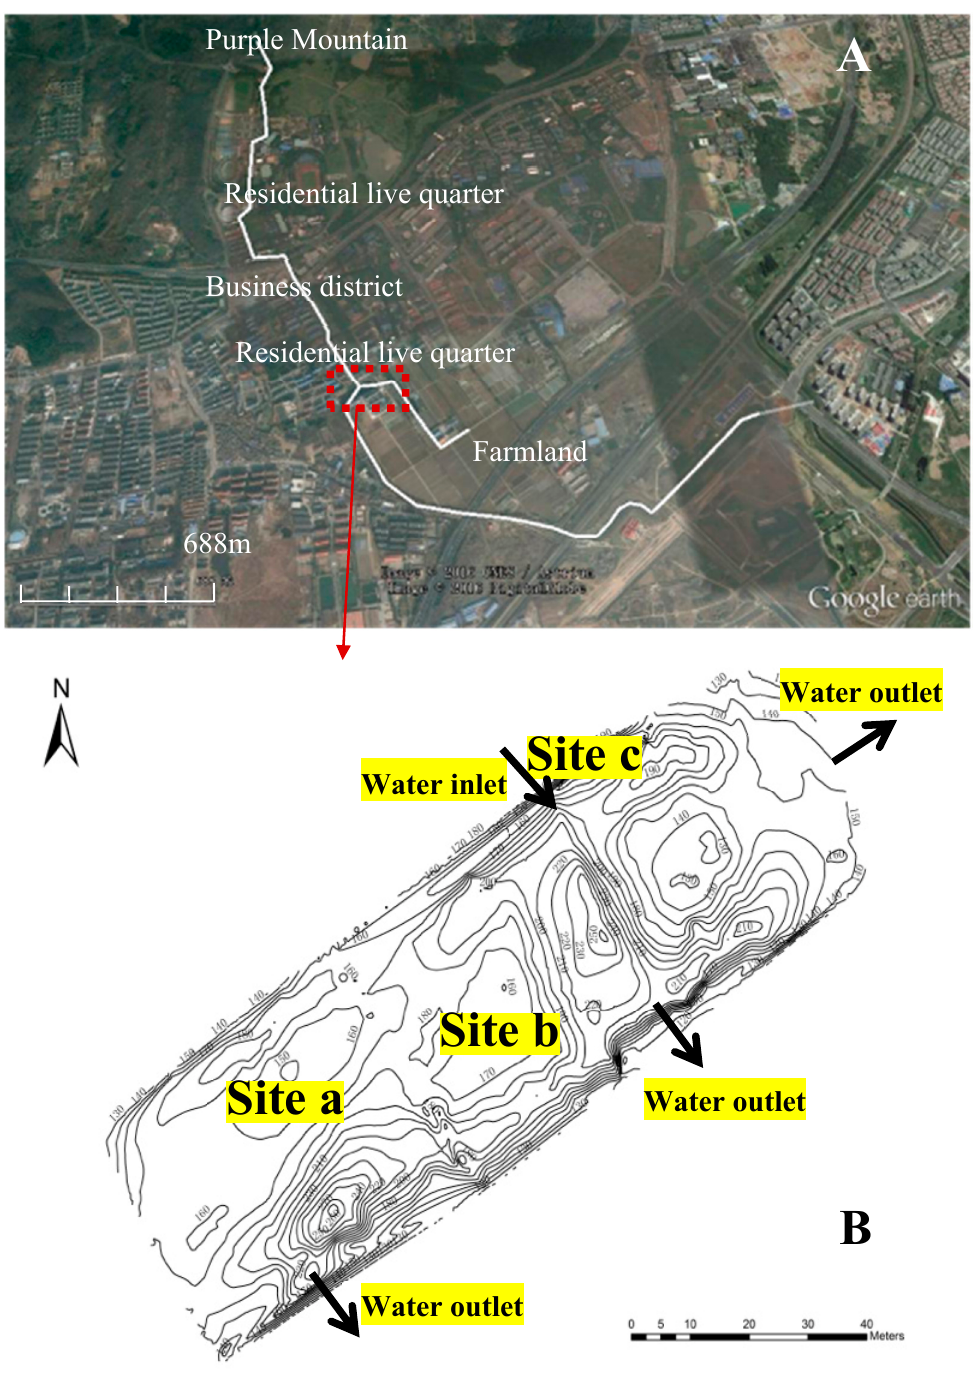
Figure 1. Detailed watershed of the eutrophic pond ( A ), locations of the sampling sites and the distribution of water depth ( B ). Numbers in plot B are the water depths (cm) of different positions in the pond, and the scale indicates the dimension of the pond.